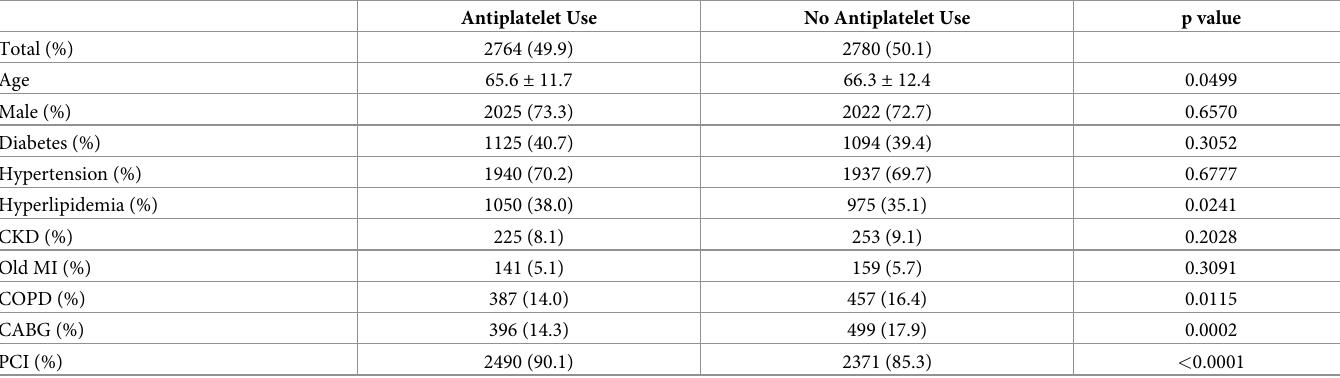
Table 2. Factors associated with antiplatelet use at 12 months.